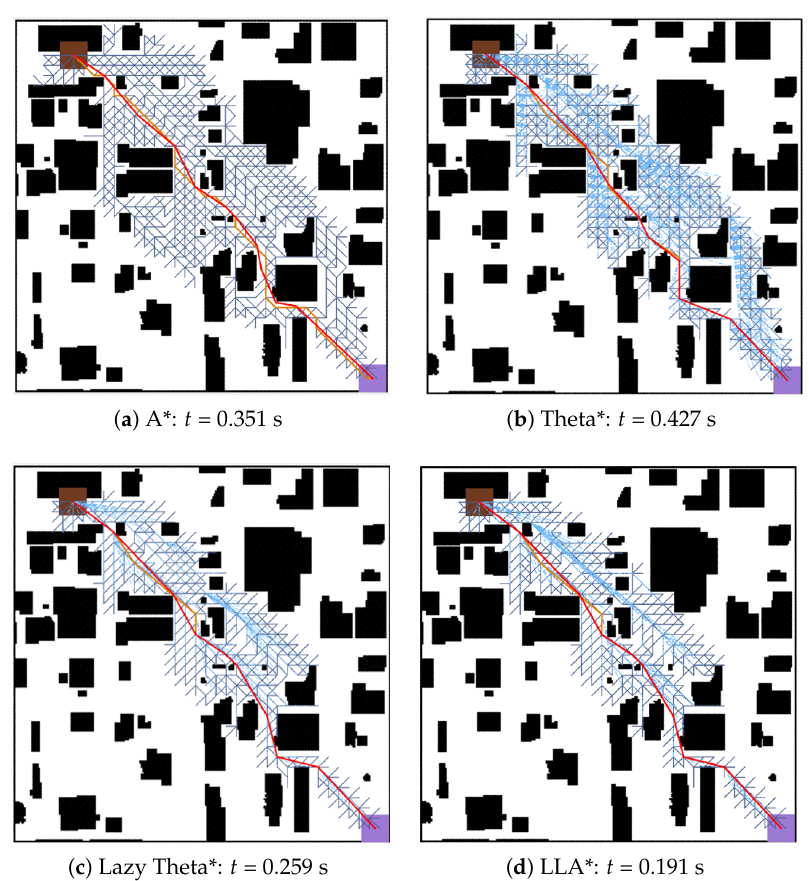
Figure 6. Extension processes of A* ( a ), Theta* ( b ), Lazy Theta* ( c ), and LLA* ( d ) on a street map. Orange lines are initial paths, and red lines are smoothed paths after the LoSS smoothing (one time of backward-LoSS and one time of forward-LoSS). ( a ) A*: initial length is 336.68, smoothed length is 320.35; ( b ) Theta*: initial length is 322.51, smoothed length is 317.79; ( c ) Lazy Theta*: initial length is 320.95, smoothed length is 316.31; ( d ) LLA*: initial length is 319.92, smoothed length is 316.31. In